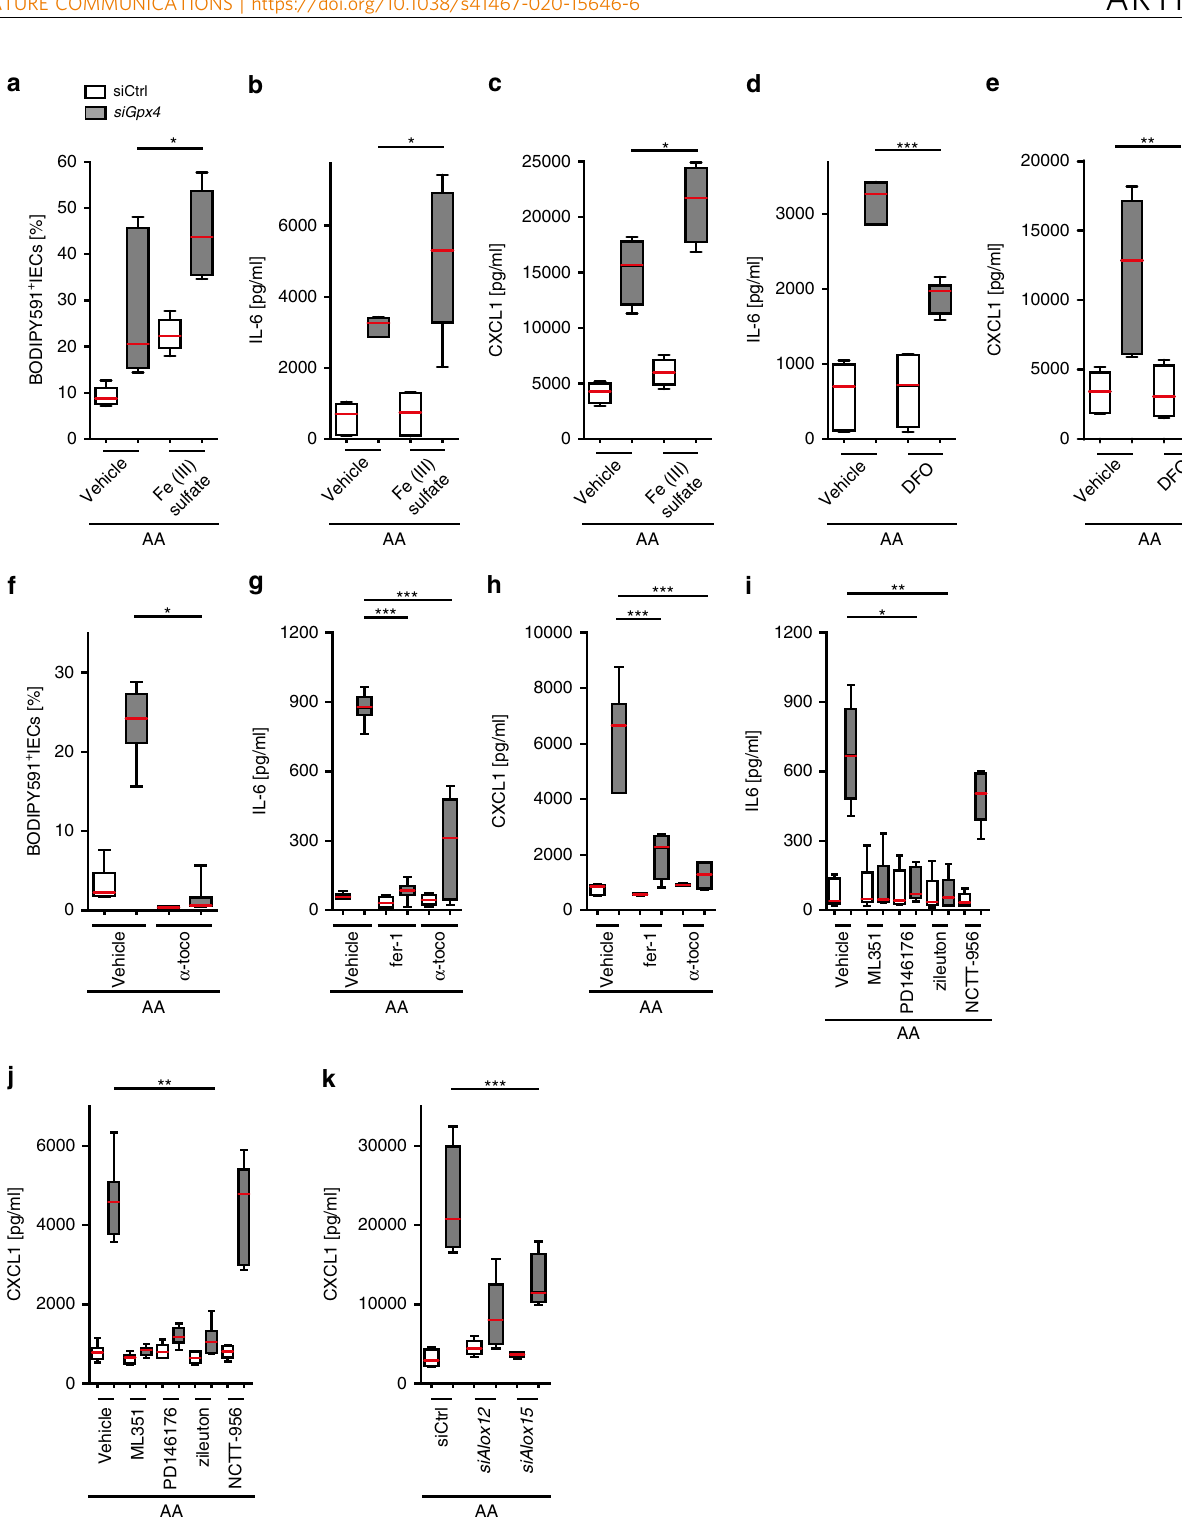
Fig. 11I, J), and NF- κ B inhibition with BAY11-7082 or MG132 abolished IL-6 production in siGpx4 IECs independent of